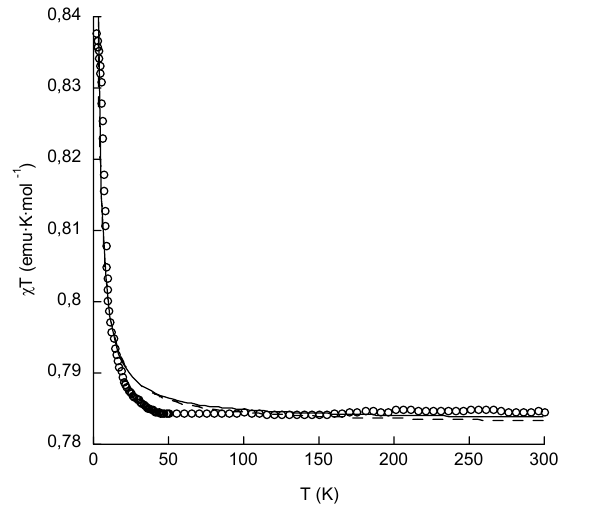
Figure 3. Temperature dependence of χ T for 1 . Solid and dashed lines correspond to the best-fit data using linear chain and dimer models,